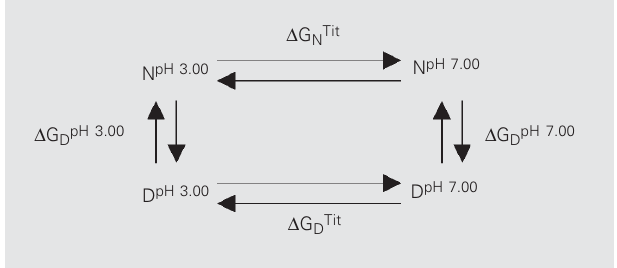
Figure 1. Thermodynamic cycle for ß-trypsin, where: ∆ G DpH 3.00 = meas- ured stability of the protein at pH 3.00; ∆ G DpH 7.00 = calculated stability of the protein at pH 7.00; ∆ G DTit = free energy change of titration of the denatured species from pH 3.00 to 7.00; ∆ G NTit = free energy change of titration of the native species from pH 3.00 to